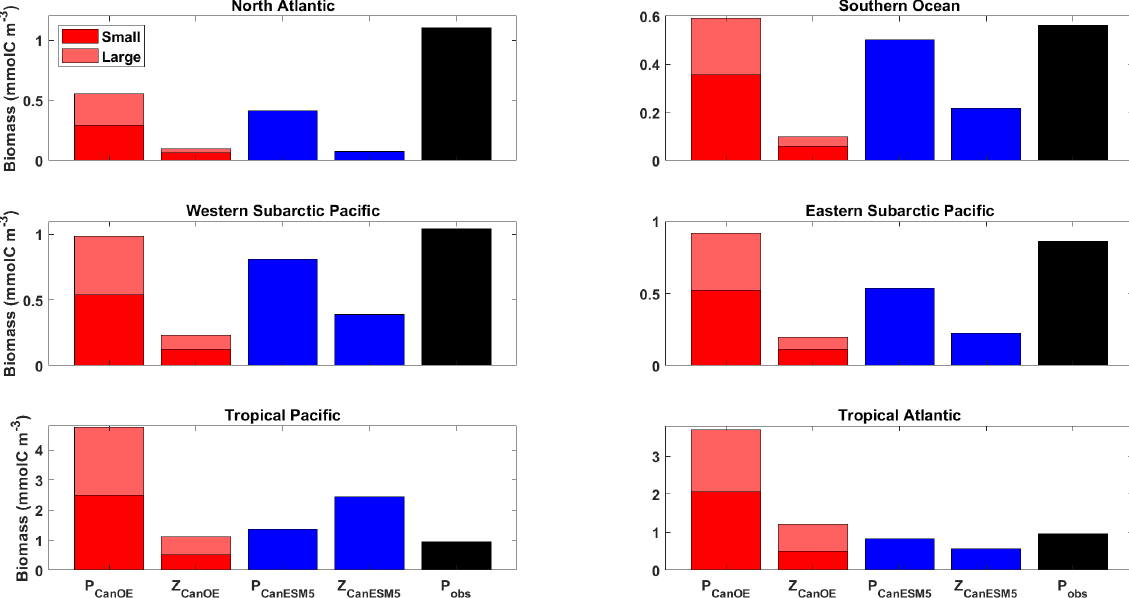
Figure 16. Annual mean surface ocean concentration of large and small phytoplankton and zooplankton in CanESM5-CanOE (red) and of phytoplankton and zooplankton in CanESM5 (blue) for the representative ocean regions shown in Fig. 14. Observational estimates (black) are for phytoplankton biomass calculated from satellite ocean colour estimates of surface chlorophyll (SeaWiFS/MODIS; Tesdal et al. 2016), assuming a carbon-to-chlorophyll ratio of 50gg − 1 . Region definitions are given in Table S5 and Fig. S5.